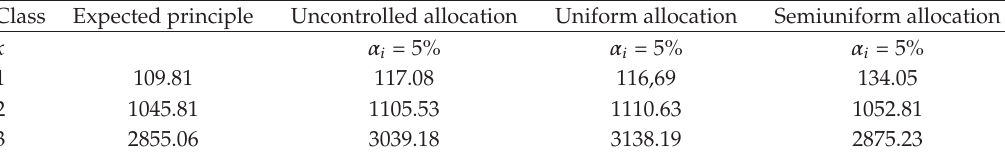
Figure 3: 3rd class of a heterogeneous Portfolio, during 100 unit-time period (cid:5) an enlargement region, where the results are more clear (cid:7) . Table 2: Optimal premium